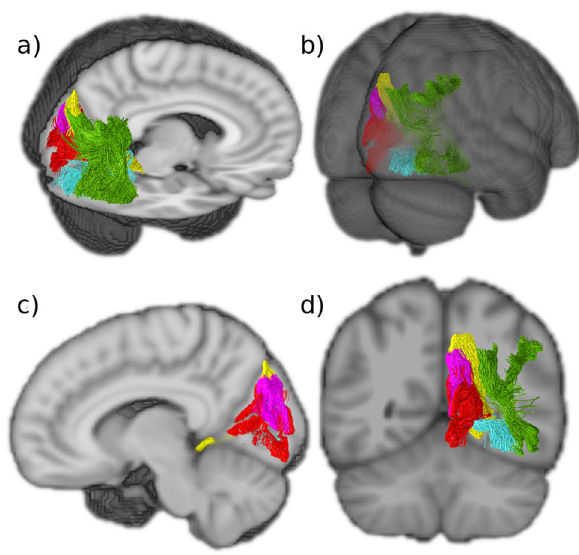
Fig. 6 The fi ve intralobar fi bers identi fi ed in the occipital lobe. Tracts generated from group averaged data of 24 subjects. a Sagittal and axial view. b Posterior view. c Sagittal view showing that the SPC is more medial than the SRF and that the SC extends more widely than the other medial intralobar tracts. d Coronal view showing that the intralobar fi bers connect all aspects of the occipital lobe. VOF vertical occipital fasciculus (green), SRF sledge runner fasciculus (yellow), SPC stratum proprium cunei (magenta), SC stratum calcarinum (red), TFV putative transverse fasciculus of the lingual lobule of Vialet